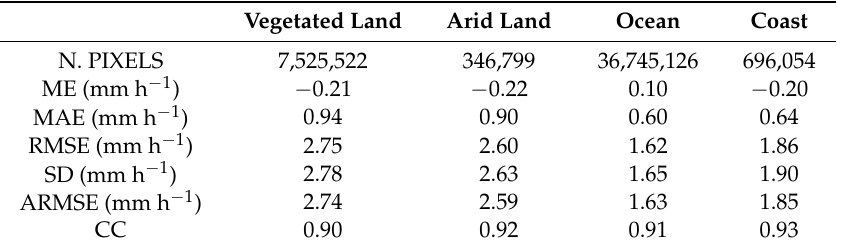
Table 7. Statistical indexes obtained in the comparison of PNPR v3 and 2B-CMB